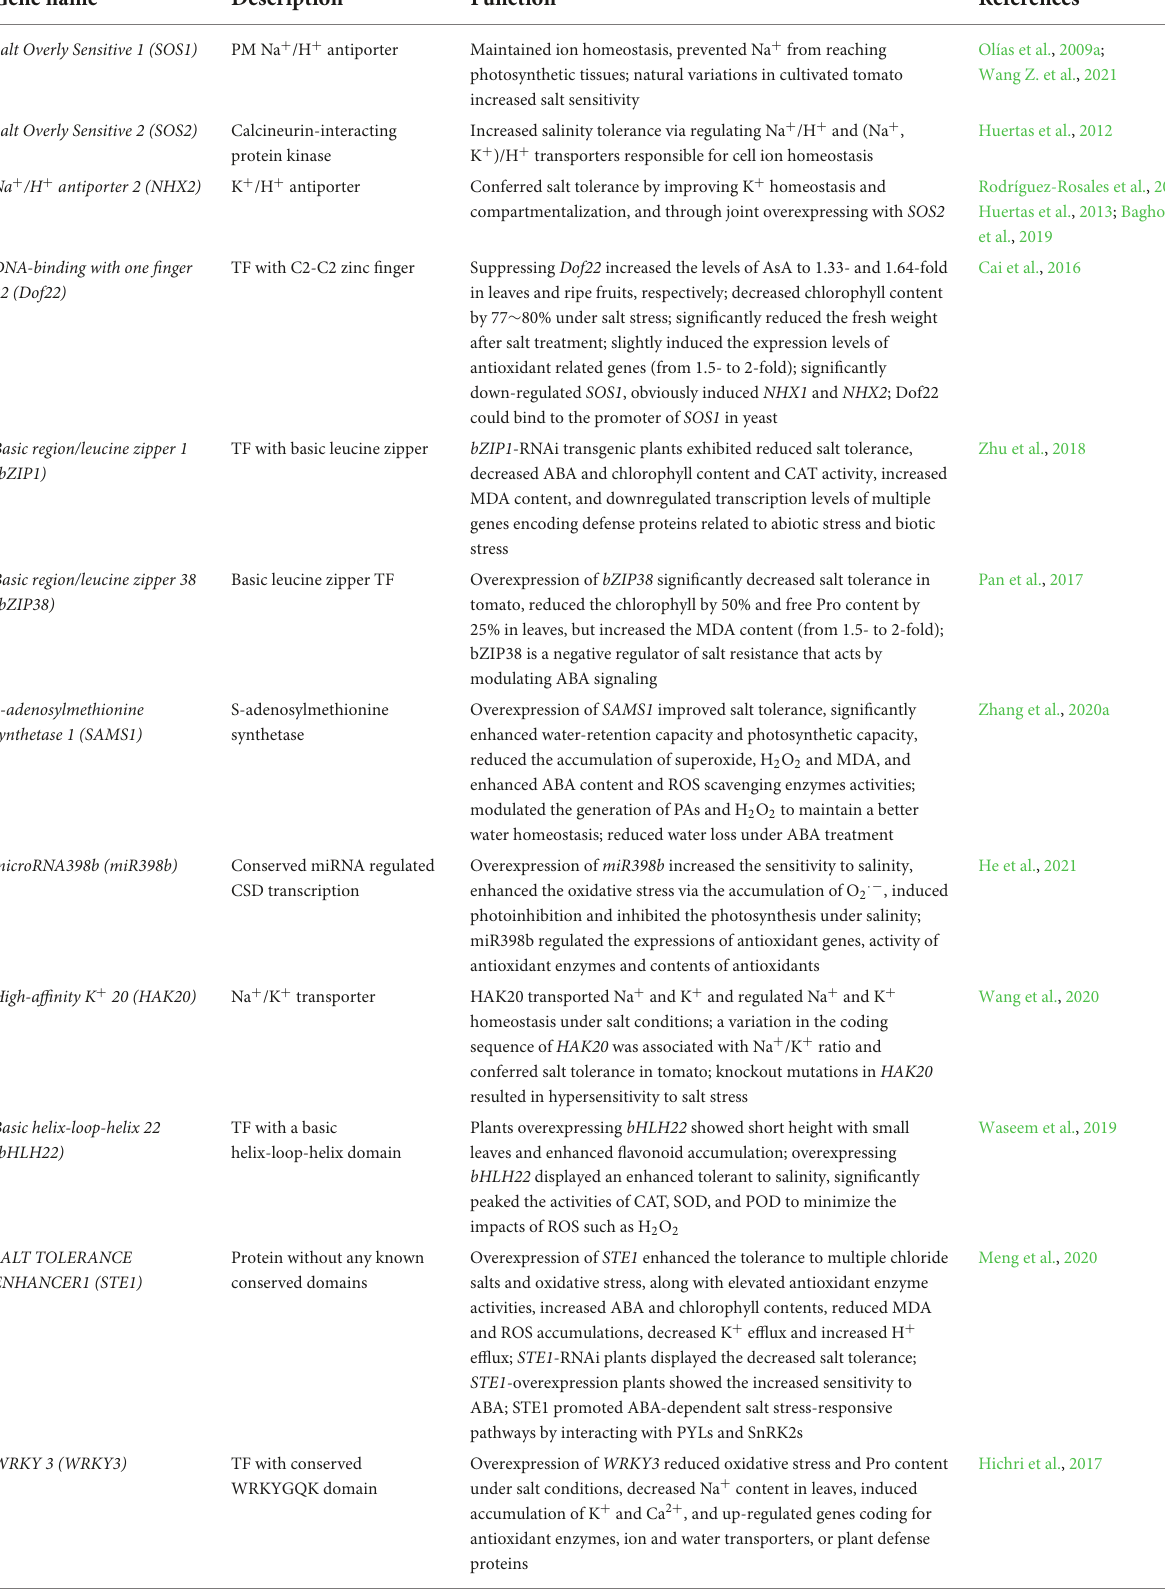
TABLE 1 Summary of genes involved in salt stress in